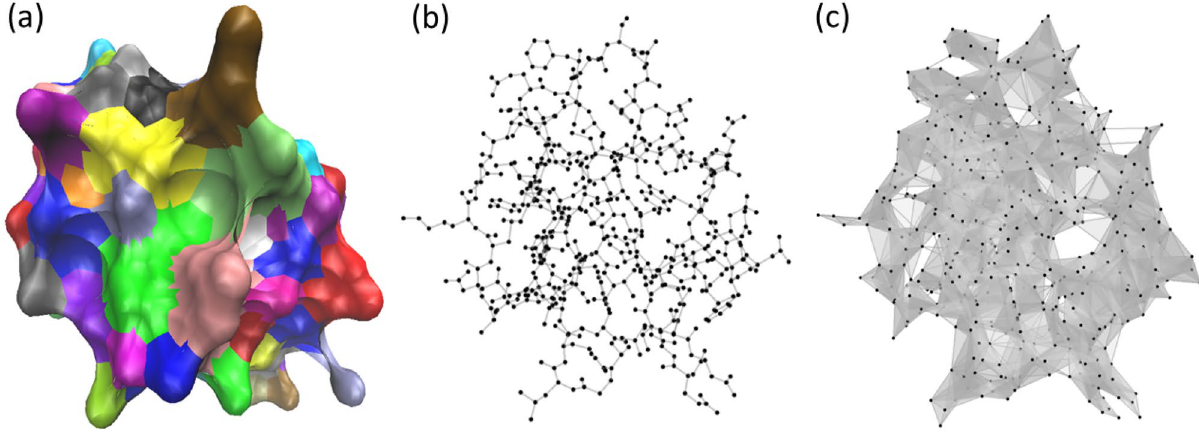
Figure 1. The comparison of molecular graph and simplicial complex representations for a protein (ID:2OFS). ( a ) Surface representation for protein 2OFS. ( b ) A graph representation for protein 2OFS. ( c ) The simplicial complex model for protein 2OFS. A simplicial complex can be viewed as a generalization of graph into its higher dimensional counterpart. Vertices (0-simplexes) and edges (1-simplexes) from graphs can be extended to higher dimensional elements, including triangles (2-simplexes) and tetrahedrons